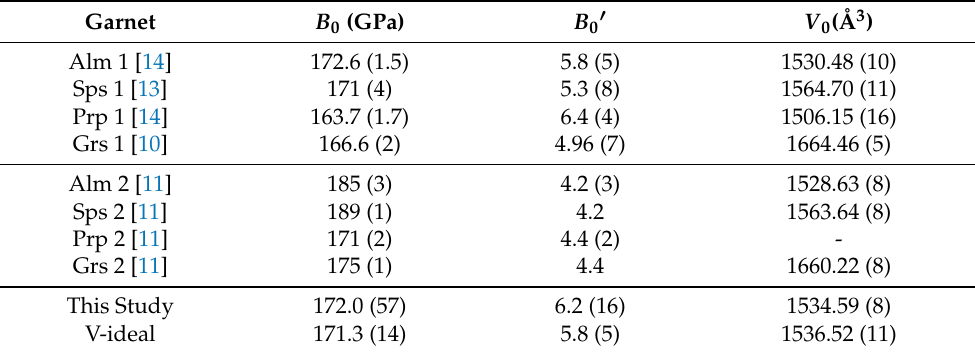
Table 2. Bulk moduli B 0 and Volume V 0 for garnet end-members from (1) the most recent experi- mental data [10,13,14], (2) internally consistent data [11], and (3) the garnet analyzed in this study and calculated assuming ideal mixing of the end-members weighted by the EPMA composition.